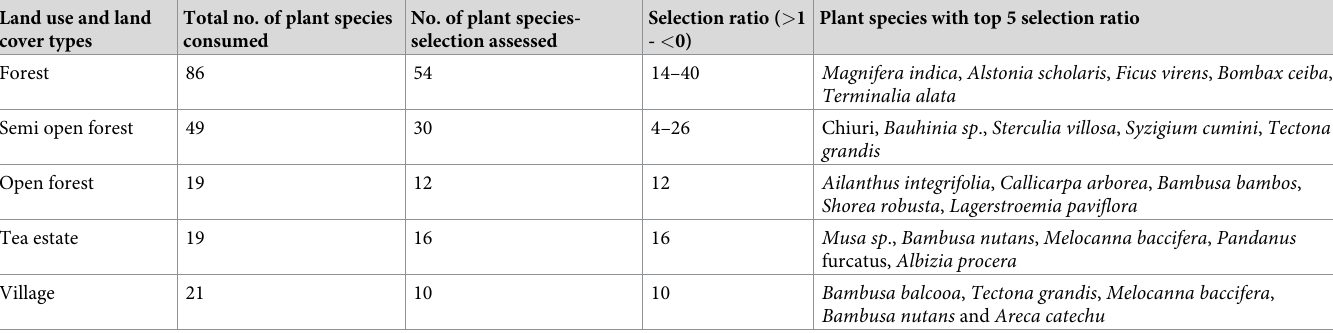
while the rest was composed of bamboos, palms, herbs, orchids, and food grains. Tree species have been found to dominate the forage intake in tropical dry forests [24] while non-tree Table 1. Representing the species with the top five selection ratios in different land use and land cover type. Land use and land cover